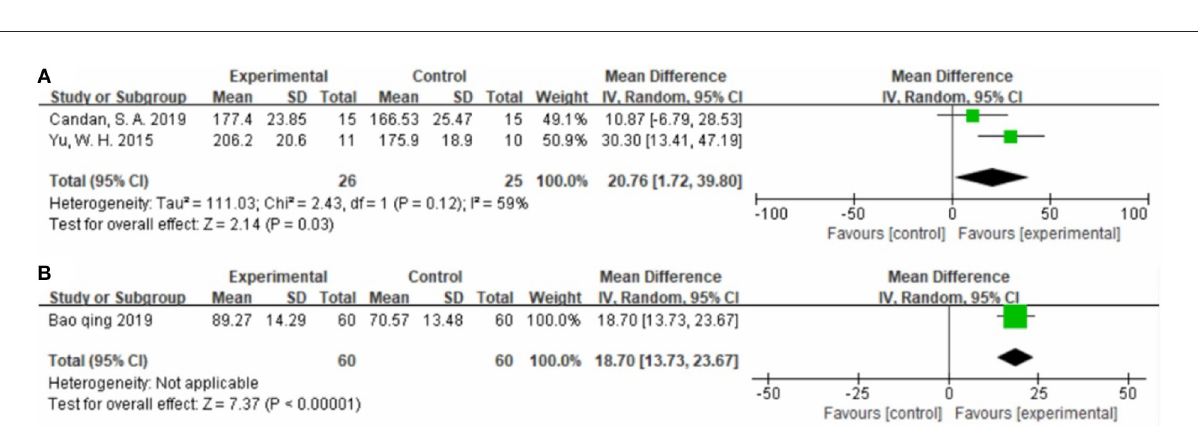
FIGURE7 Forest plot. CIMT vs. conventional physiotherapy on the stroke-specific quality of life questionnaire (A) and World Health Organization quality of life assessment (B) .